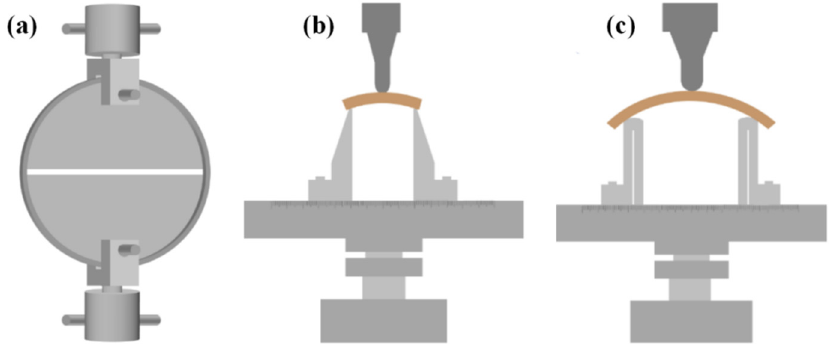
Figure 3. Testing of mechanical performance of NOL rings. ( a ) Tensile performance testing; ( b ) shear performance testing; ( c ) bending performance